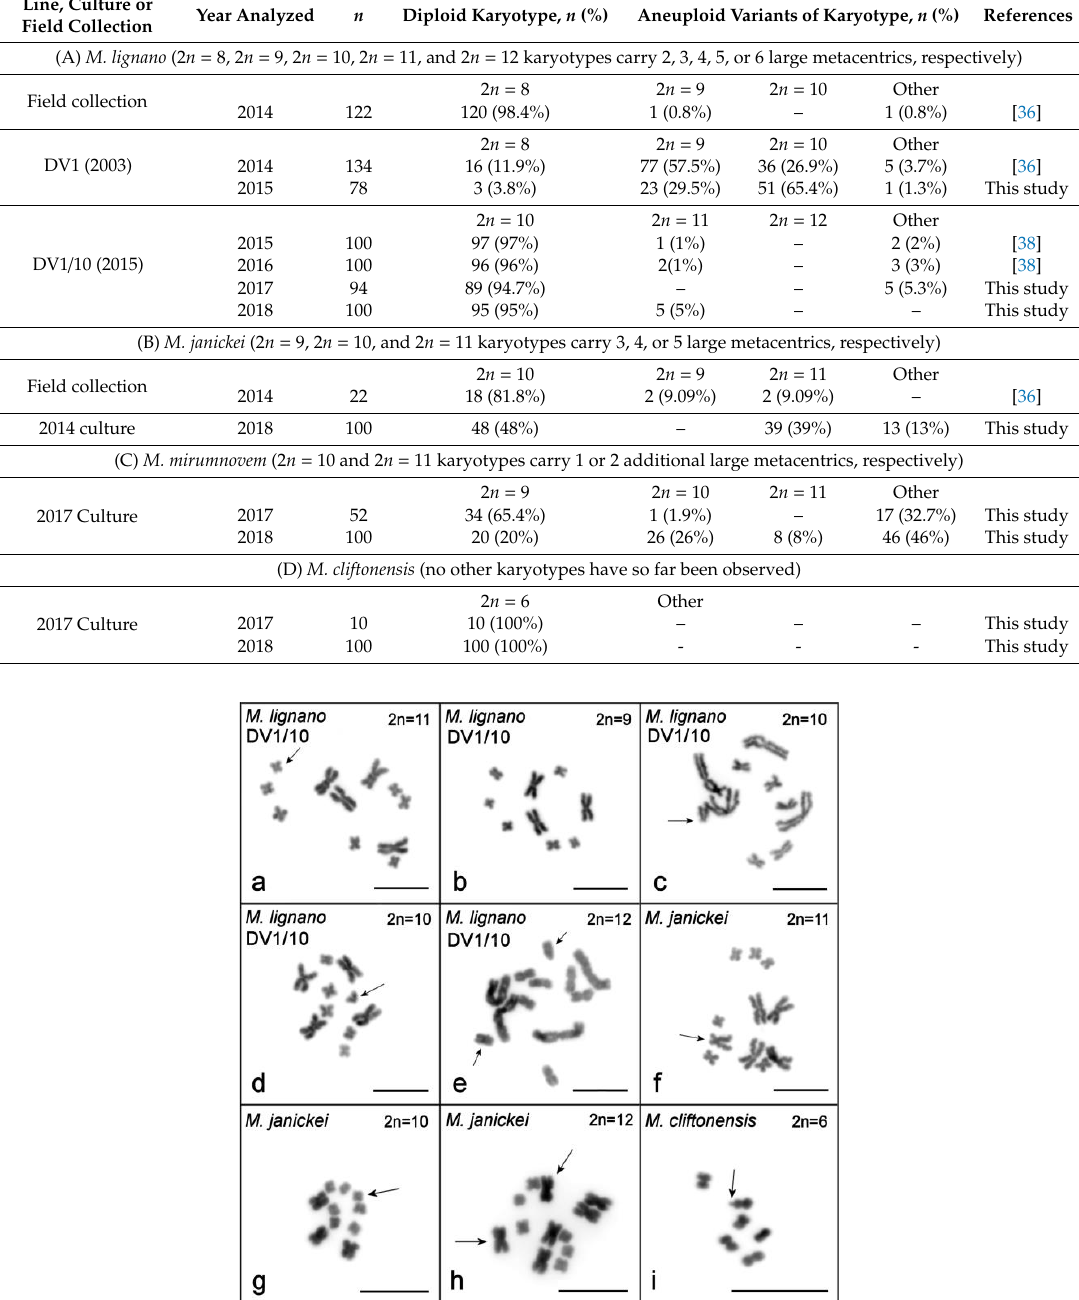
Table 1. Single-worm karyotyping of specimens of the four studied Macrostomum species.